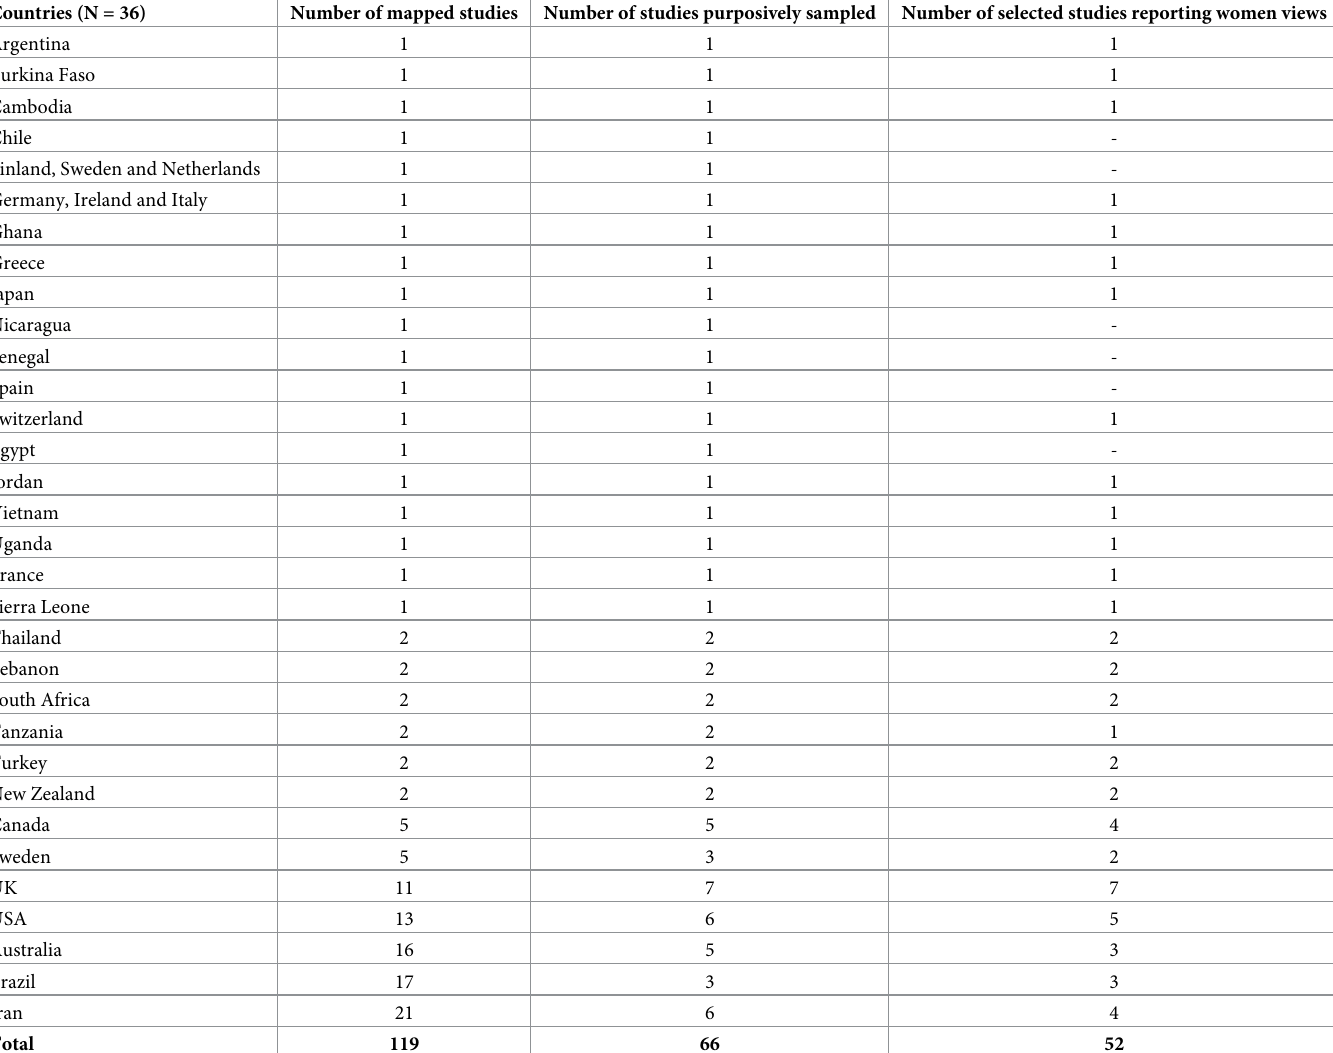
Table 1. Number of studies mapped, sampled and included by